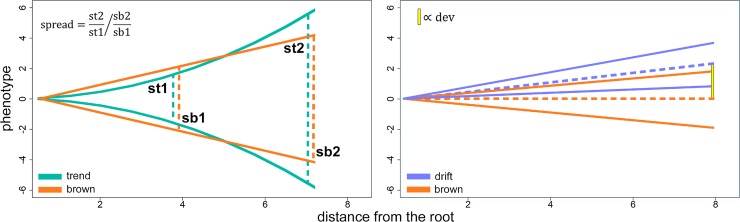
The application of phenotypic drift (left) and trend in rate variation (right) develped by the RRphylo function setBM and used in the simulations described in this study. For both transformations, a metric (dev for phenotypic drift, spread for rate trend) measures the deviation of the transformed phenotype from the Brownian motion model.